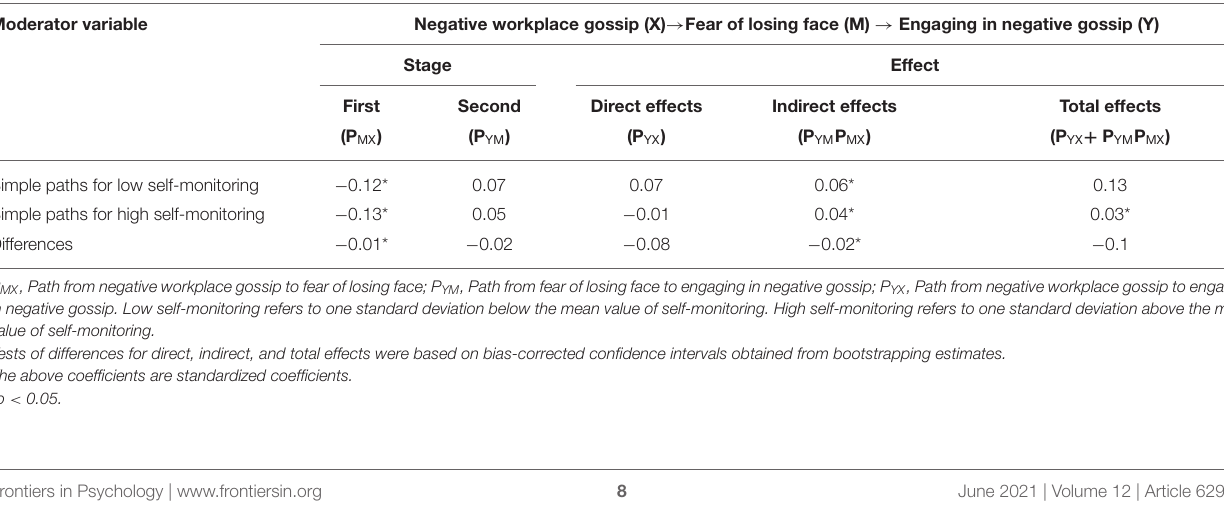
TABLE 6 | Supplementary results of the moderated path